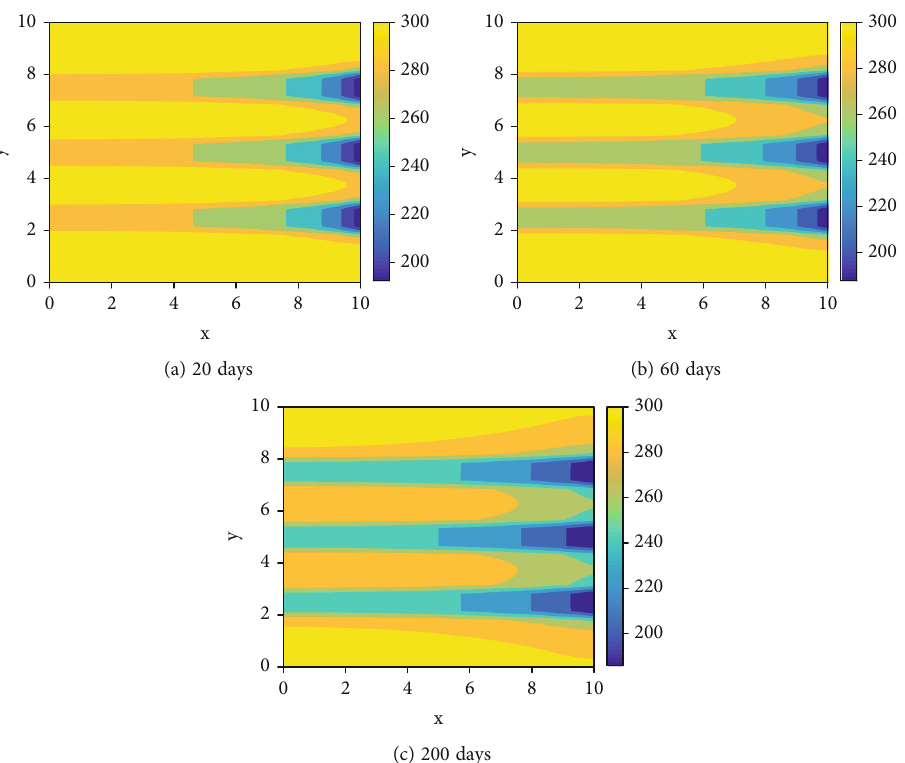
= 60 mol/m 3 at di ff erent b